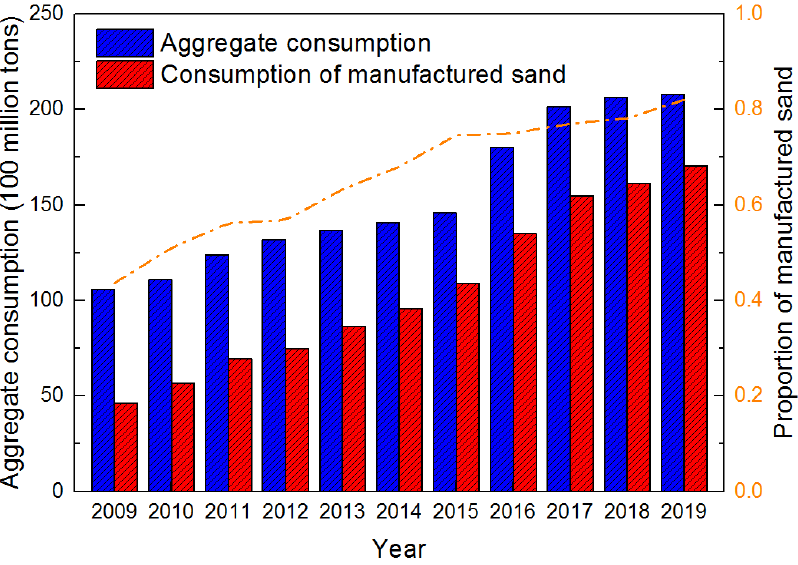
Figure 1. Aggregate consumption and proportion of manufactured sand in China.